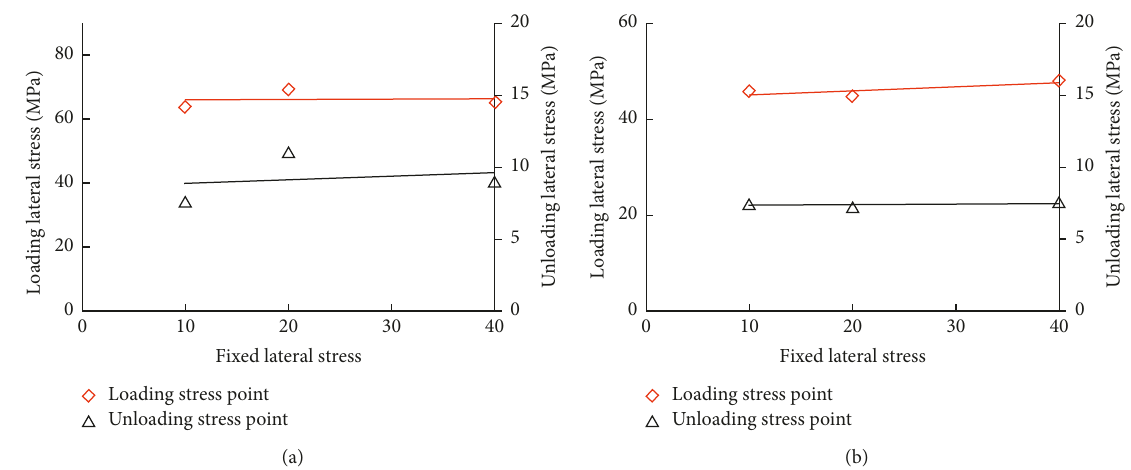
Figure 9: Stress-initial fixed lateral stress data. (a) Peak stress; (b) Yield stress.